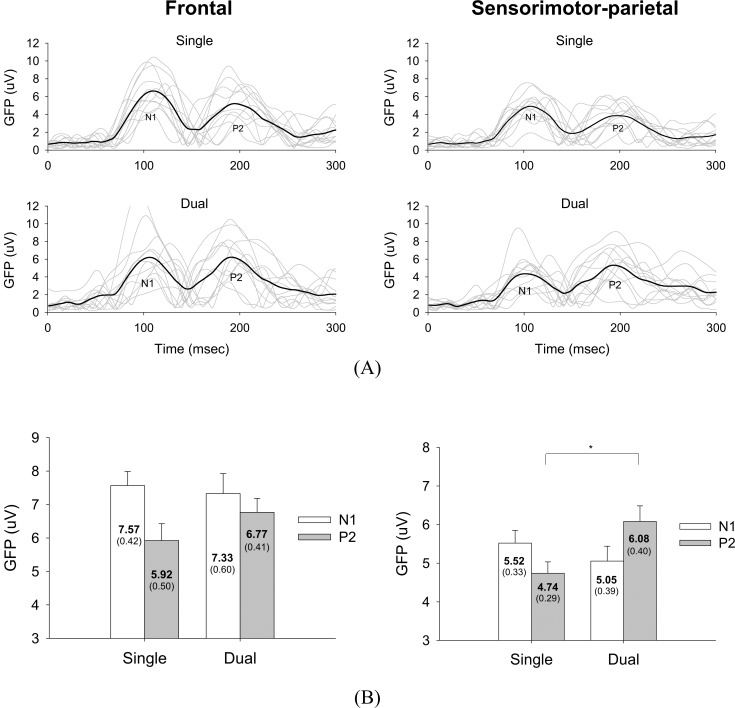
Global field power (GFP) of the single-posture and dual-task conditions.(A) Temporal profiles of GFP for all subjects. Black-bold lines indicate subject-averaged GFP profiles (n = 12). (B) The contrasts of peak GFP of the N1 and P2 components between the single-posture and dual-task conditions (left plot: frontal area; right plot: sensorimotor-parietal area)(*: p < .05).